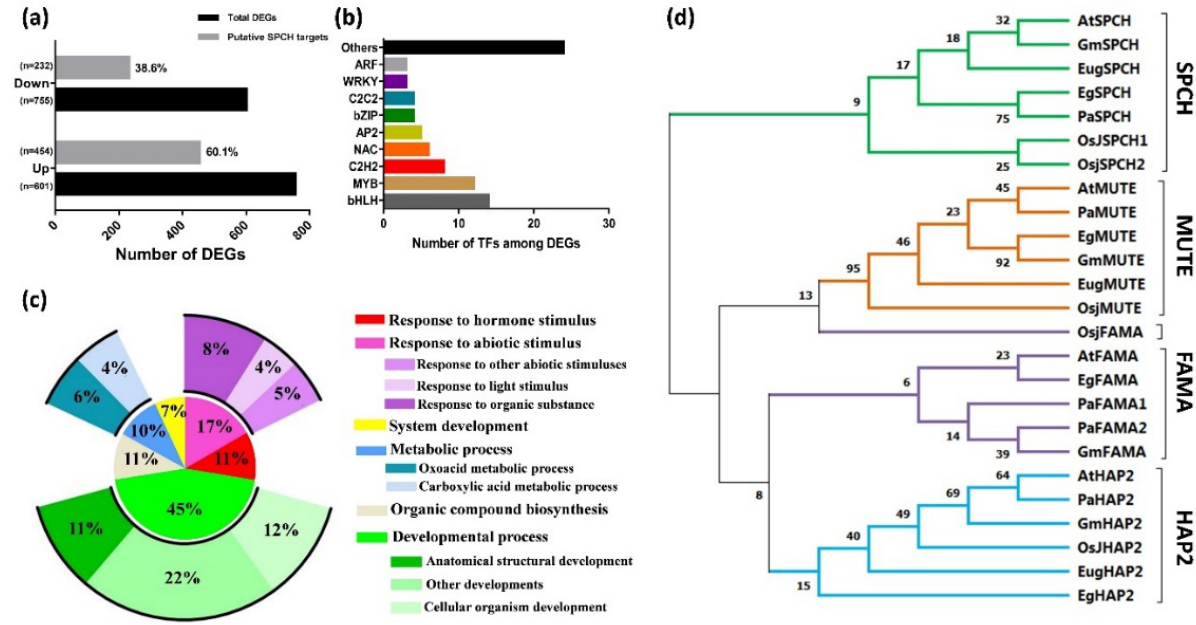
Figure 4. ( a ) Percentage of putative EgSPCH target DEGs in RNA-seq analysis. ( b ) The number of transcription factors among EgSPCH putatively targeted DEGs. ( c ) Enriched GO terms of EgSPCH targets. ( d ) The phylogenic analysis of the protein of SPCH and its two homolog transcription factors, MUTE and FAMA, in Arabidopsis ( At ), japonica rice ( Osj ), soybean ( Gm ), Elaeis guineensis ( Eg ), Eucalyptus grandis ( Eug ), and Populus alba L ( Pa ). Bootstrap = 500. The percentage of replicate trees in which the associated taxa clustered together in the bootstrap test (500 replicates) are shown next to the branches.